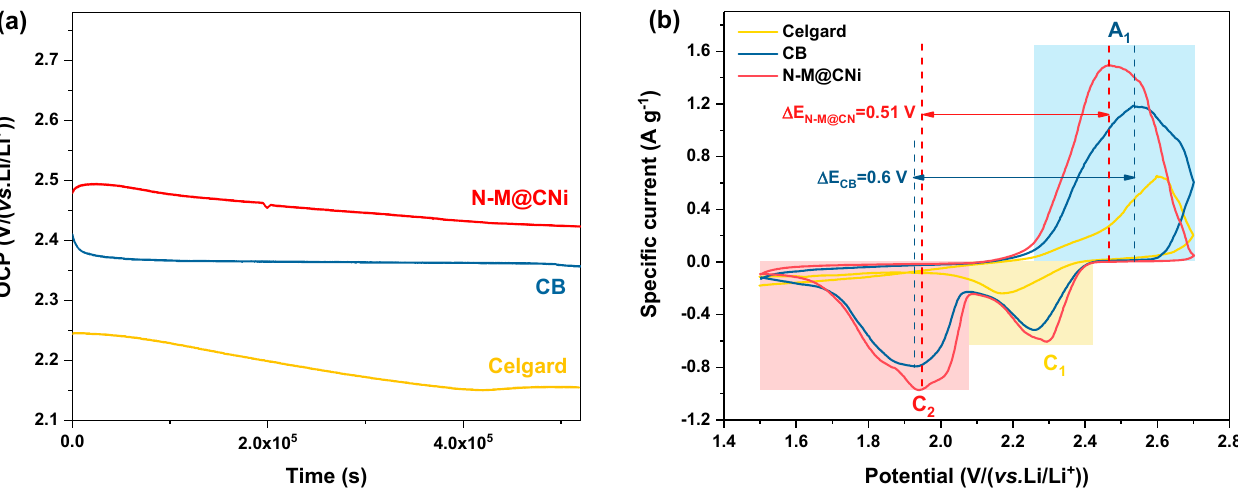
2.35 V after only 5.2 × 10 5 s ( − 2.88 × 10 − 1 mV h − 1 ). This prominent anti-self-discharge effect Figure 4. ( a ) OCP test of cells with N-M@CNi or CB-modified separator, or with pristine Celgard of the N-M@CNi separator is due to its adsorption effect that effectively inhibits the loss separator. ( b ) Cyclic voltammetry curves of cells with N-M@CNi- or CB-modified separator, or with of the LiPS. pristine Celgard separator. The sulfur loading in the tested cathode was ~2.3 mg cm − 1